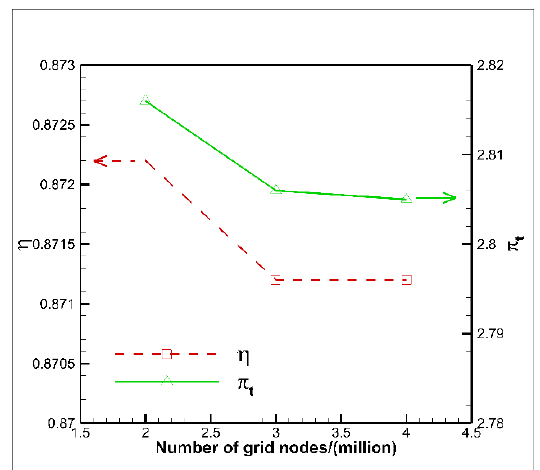
Figure 4. Compressor performance with different numbers of grid nodes at the optimization point.